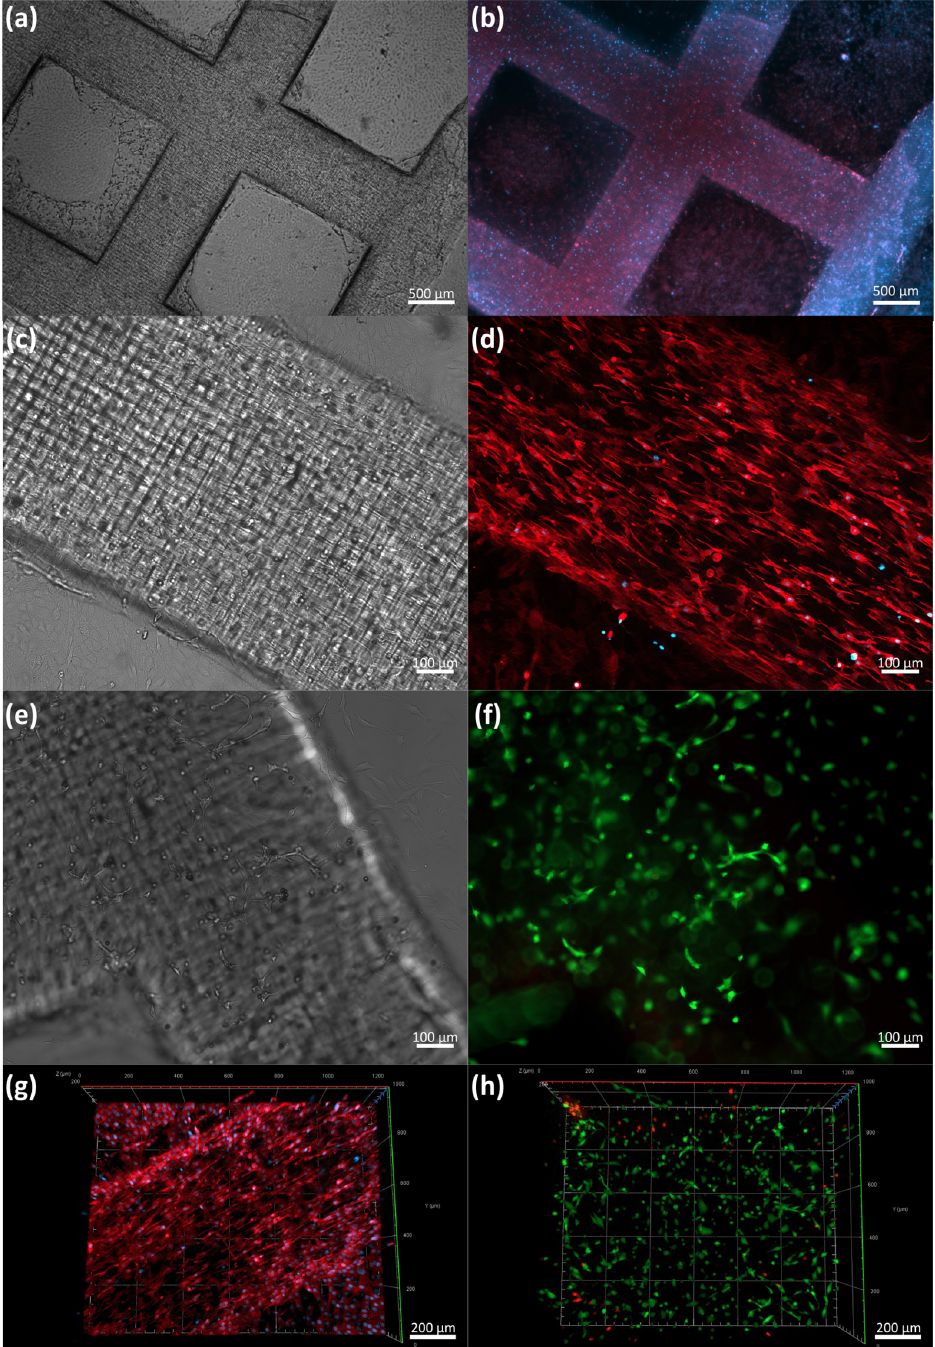
Figure 8. Proof-of-concept cell seeding: ( a ) bright field image of 3D-printed GelMA (10%) construct laden with C2C12 after 5 days of culture, ( b ) Actin-Dapi staining of whole construct, ( c ) detail of bright field image of 3D-printed GelMA (10%) construct laden with C2C12 after 5 days of culture, ( d ) detail of of Actin-Dapi staining ( e , f ) bright field and Live/Dead fluorescence assay after 5 days of culture, and ( g , h ) orthogonal reconstruction of Z‑stack images of Actin‑Dapi staining and Live/Dead fluorescence